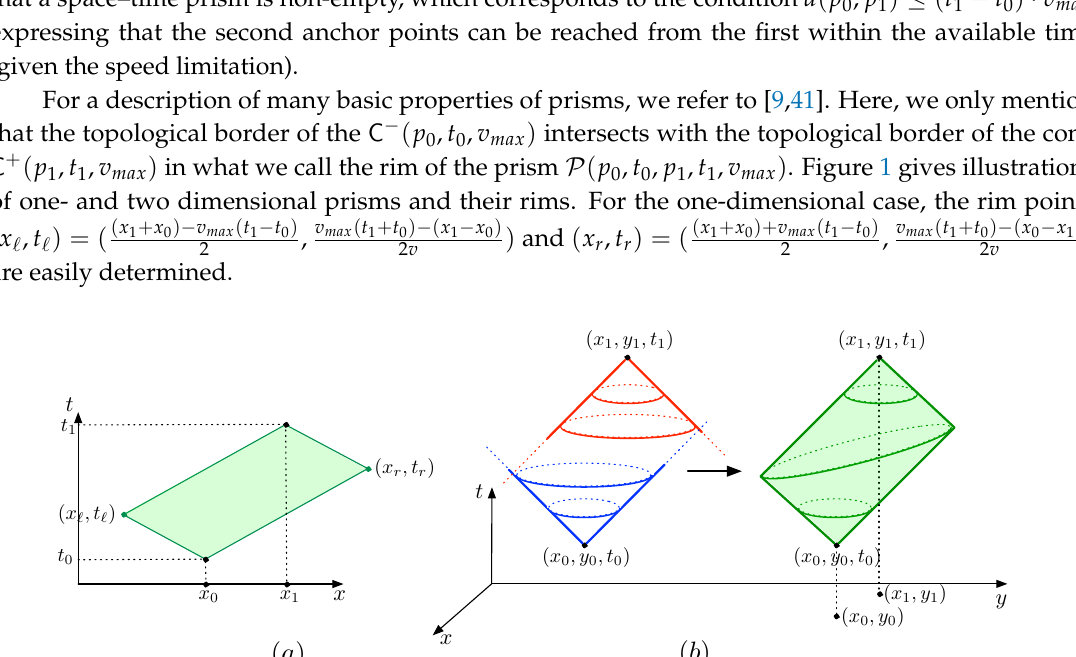
Figure 1. On the left ( a ), a one-dimensional prism is shown. On the right ( b ), a space–time prism movement in R 2 . This prism is the intersection of the past cone C + ( x 1 , y 1 , t 1 , v max ) (in red) and the future cone C − ( x 0 , y 0 , t 0 , v max ) (in blue). The rim ρ